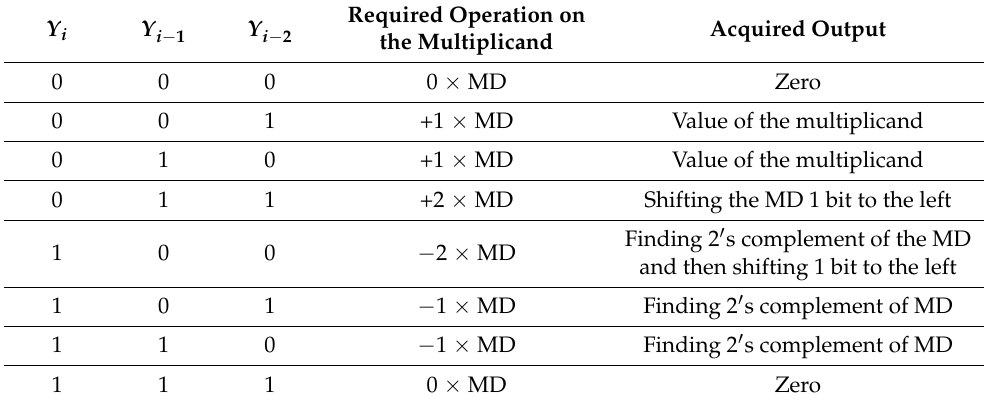
Table 2. Radix-4 Modified Booth encoding table.